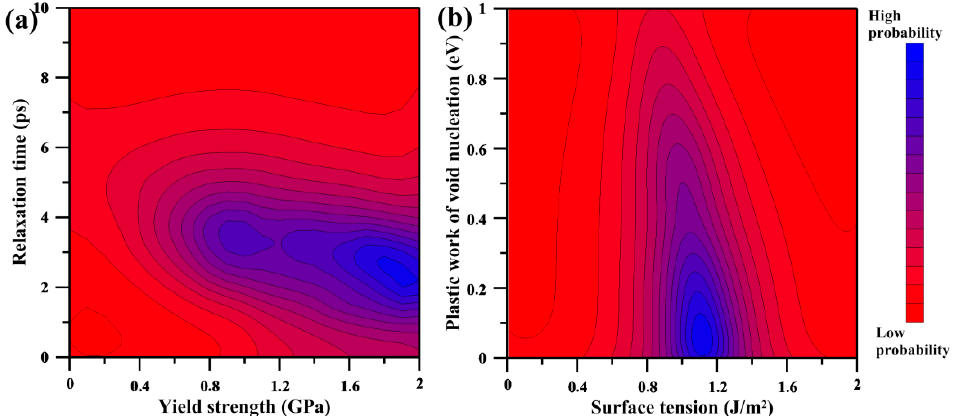
Figure 4. Bayesian identification of parameters: Probability distributions in the space of model pa- rameters for solid copper at the increased temperature of 1000 K; 80,000 parameter points. Subfigures show distributions along the following pairs of parameters: ( a ) the yield strength and the relaxation time; ( b ) the surface tension and the plastic work of nucleation. Table 2. Identified parameters of the fracture model (copper): γ is the surface tension coefficient; W p is the plastic work of void nucleation in solids; Y is the yield strength; τ is the relaxation time; η is the viscosity coefficient.